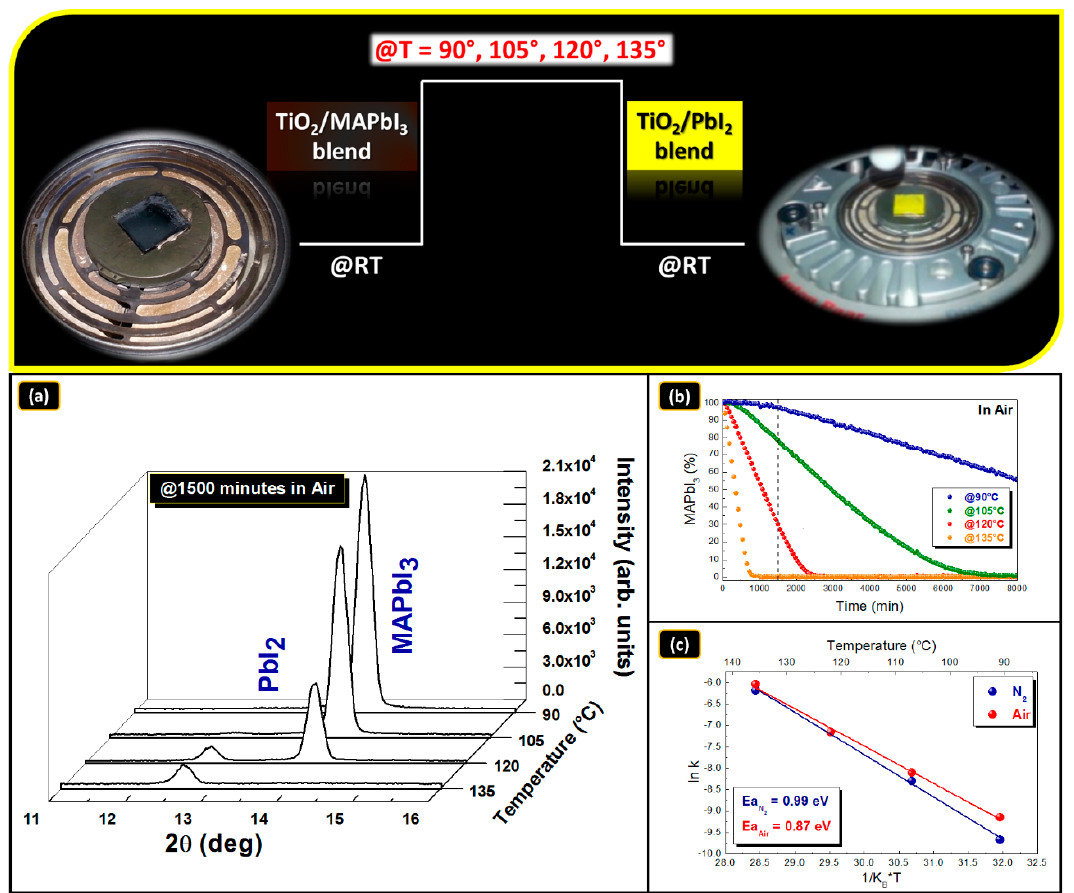
Figure 7. ( a ) XRD patterns collected after at 1500 min annealing in air at different temperatures; ( b ) kinetic analysis and fitting of the degradation curves of blend samples annealed at four different temperatures (90 °C, 105 °C, 120 °C and 135 °C) in air; ( c ) Arrhenius plot of the kinetic constant and activation energy extracted in air and dry N 2 environment. All data were collected in dark conditions.